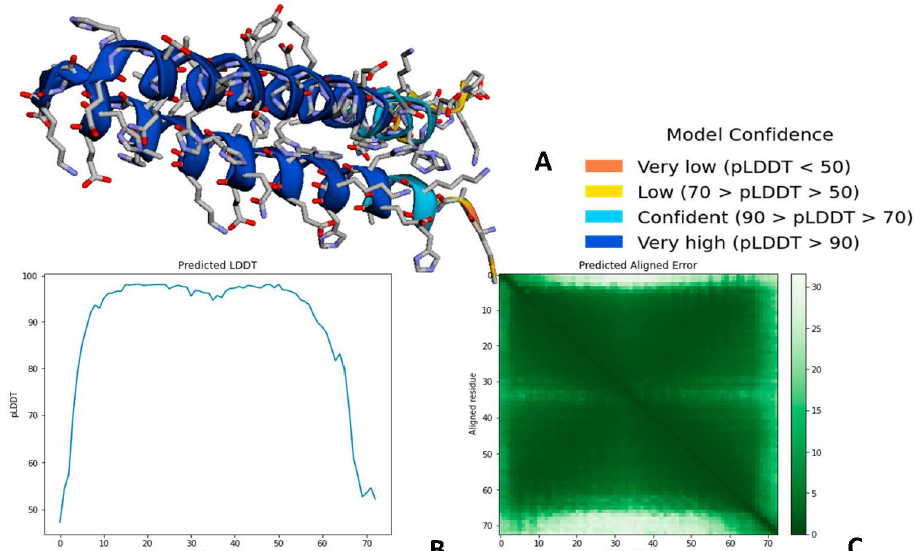
Figure 6. The three outputs of AlphaFold v.2.1.0. online tool. ( A ) Predicted 3D structure of Bg_9562 using AlphaFold 2. The predicted model has very high confidence levels of pLDDT > 90. ( B ) The predicted LDDT (pLDDT) plot gives best information on intra-domain confidence and it interpreted as high as pLDDT > 90. ( C ) Interactive 2D plot of Predicted Aligned Error (PAE), the dark green color at (x, y) indicated AlphaFold 2 predicted low error with well-defined relative positions from two different domains.